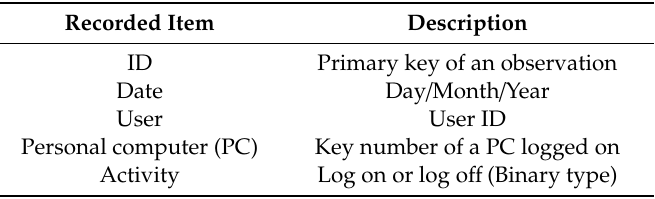
Table 1. Log records of logon